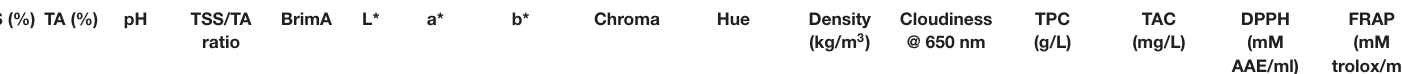
TABLE 4 | Pearson correlation coefficient matrix between physicochemical, phytochemical, and antioxidant properties. Variables